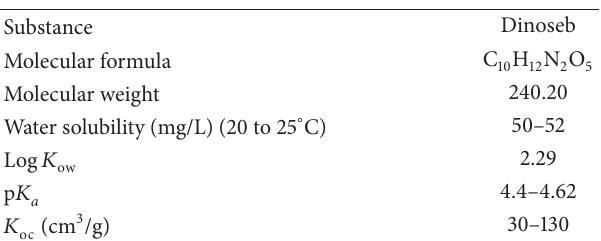
Table 1: Main properties of dinoseb